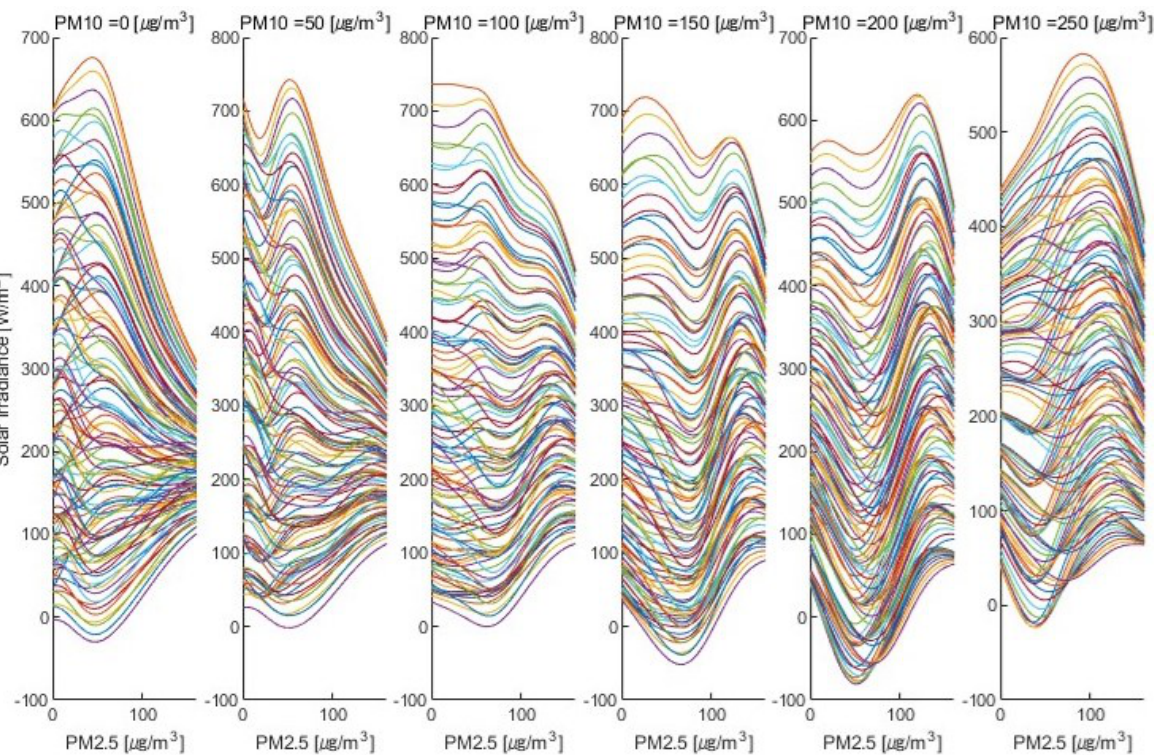
Figure 8. Neural network analysis on the influence of particulate matter (PM2.5) to the level of solar irradiation measured on the